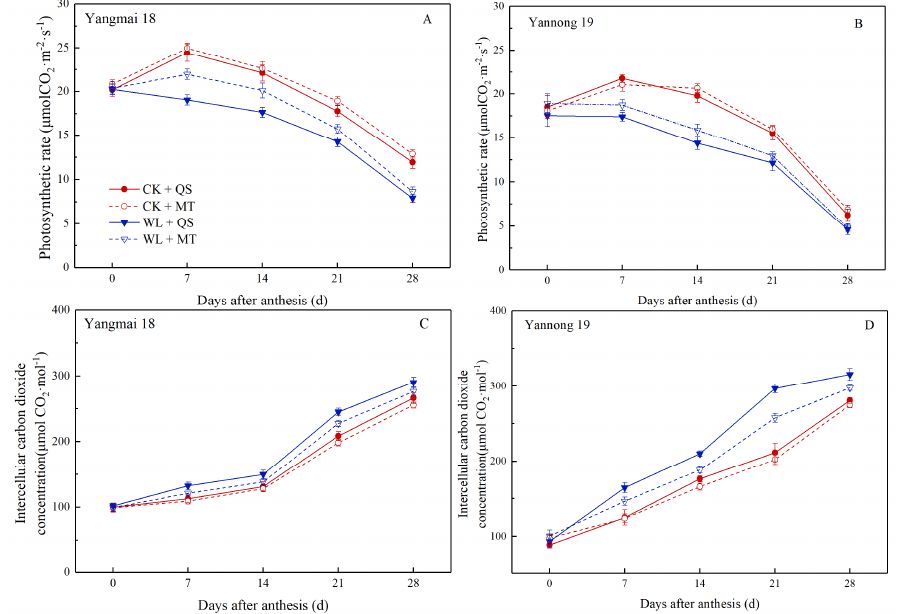
Figure 8. Post-flowering changes in the flag leaf net photosynthetic rate and intercellular CO 2 con- concentration ( A – D ) under different treatments, i.e., CK + QS: leaf spraying with distilled water under centration of Yangmai 18 ( A , C ) and Yannong 19 ( B , D ) under different treatments, i.e., CK + QS: leaf non-waterlogged conditions; CK + MT: leaf spraying with 100 µ mol · L − 1 of melatonin under non- spraying with distilled water under non-waterlogged conditions; CK + MT: leaf spraying with 100 waterlogged conditions; WL + QS: leaf spraying with distilled water under waterlogged conditions; μmol·L −1 of melatonin under non-waterlogged conditions; WL + QS: leaf spraying with distilled WL + MT: leaf spraying with 100 µ mol · L − 1 of melatonin under waterlogged water under waterlogged conditions; WL + MT: leaf spraying with 100 μmol·L −1 of melatonin under waterlogged conditions.